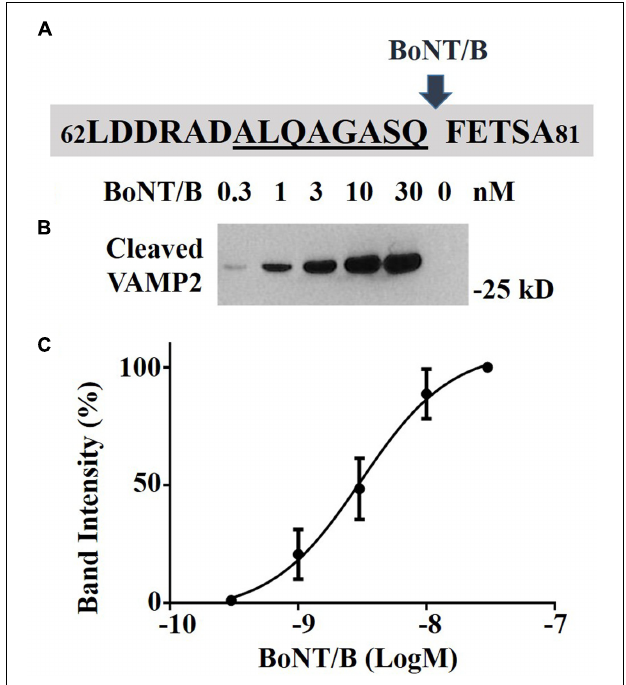
FIGURE 4 | Detection of BoNT/B activity in NanoLuc-VAMP2 SiMa cells using specific BoNT/B-cleaved VAMP2 antibody. (A) The VAMP2 amino acid sequence used for generation of the rabbit polyclonal antibody is underlined. The arrow indicates the cleavage site by BoNT/B. (B) Immunoblot showing dose-dependent increase of BoNT/B-cleaved NanoLuc-VAMP2 product using the cleaved VAMP2 antibody. Engineered SiMa cells were incubated for 60 h in the presence of indicated concentrations of BoNT/B followed by SDS–PAGE and immunoblotting. (C) Graph showing quantification of dose-dependent increase in cleaved VAMP2 immunoblotting signal in response to BoNT/B with sensitivity in the low picomolar range ( n = 3 ± SD).